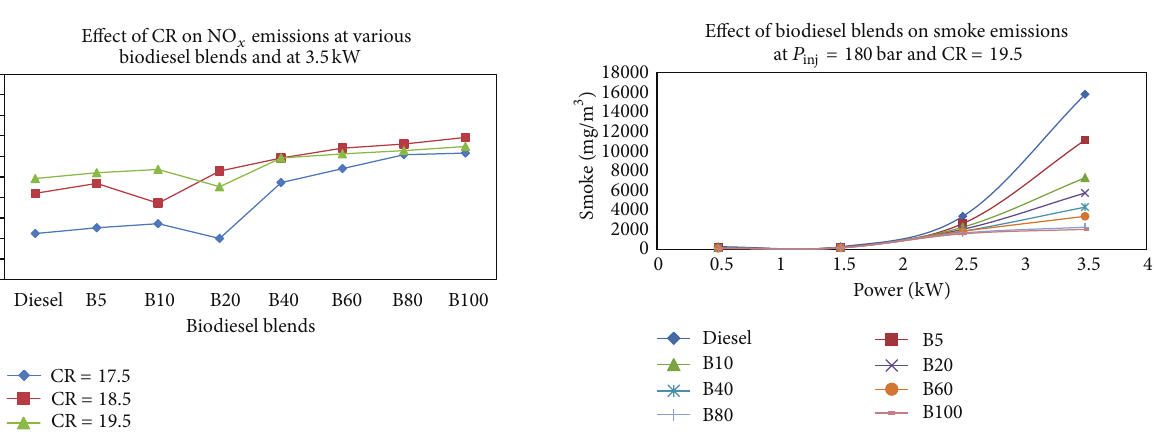
Figure 12: Variation in NO 𝑥 for various biodiesel blends at com- pression ratios 17.5, 18.5, and 19.5.